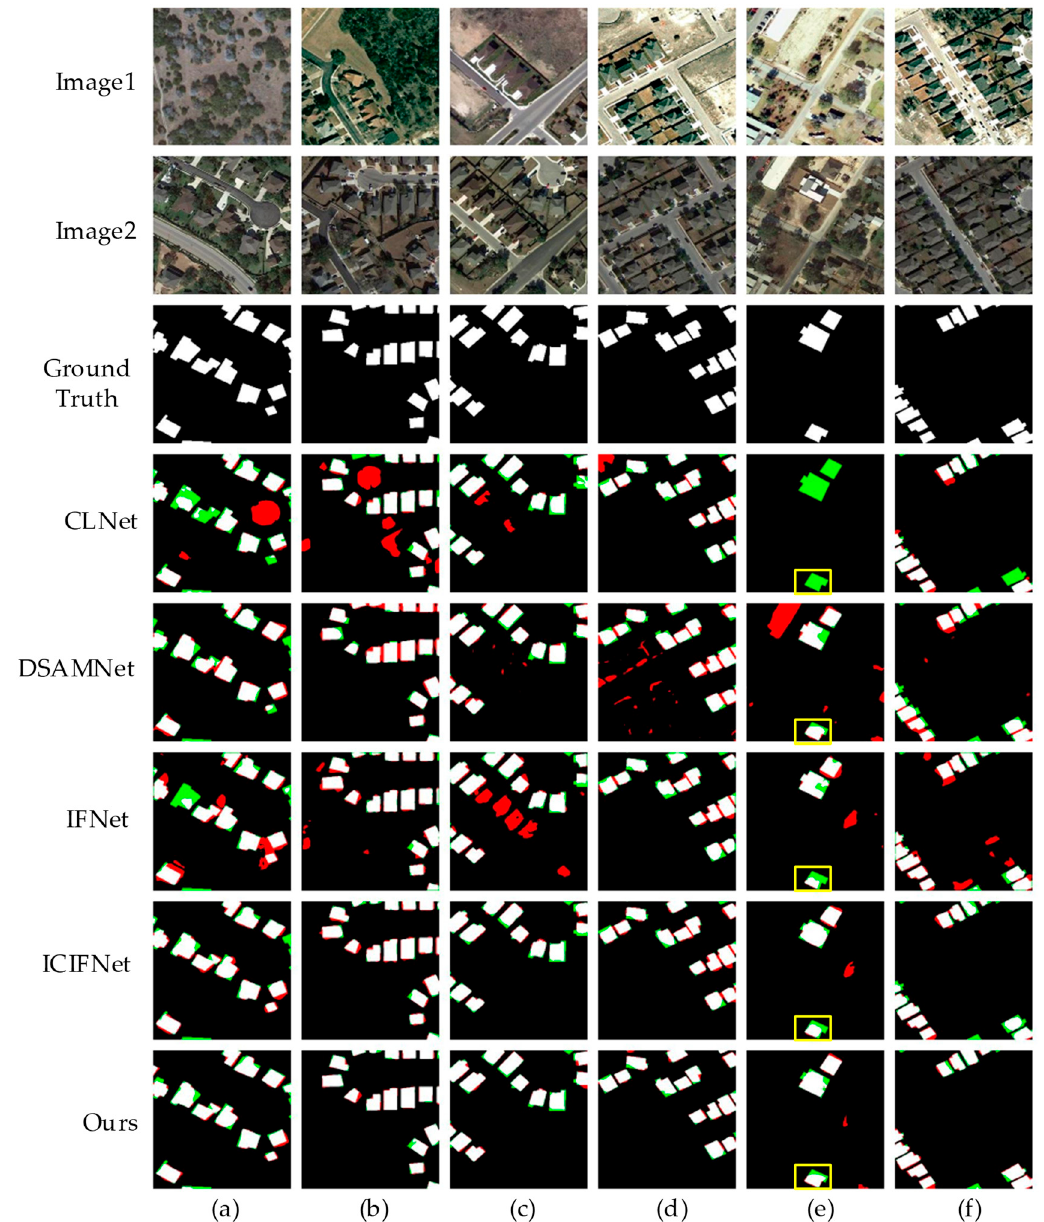
Figure 4. Illustrations of BuCD results on the LEVIRCD dataset. Six pairs of multi-temporal images are shown from ( a – f ). White represents the correctly identified changing buildings. Additionally, red and green denote the false and missed predictions of changed buildings, respectively. The yellow boxes of ( e ) show that five networks could not identify the changed rooftop